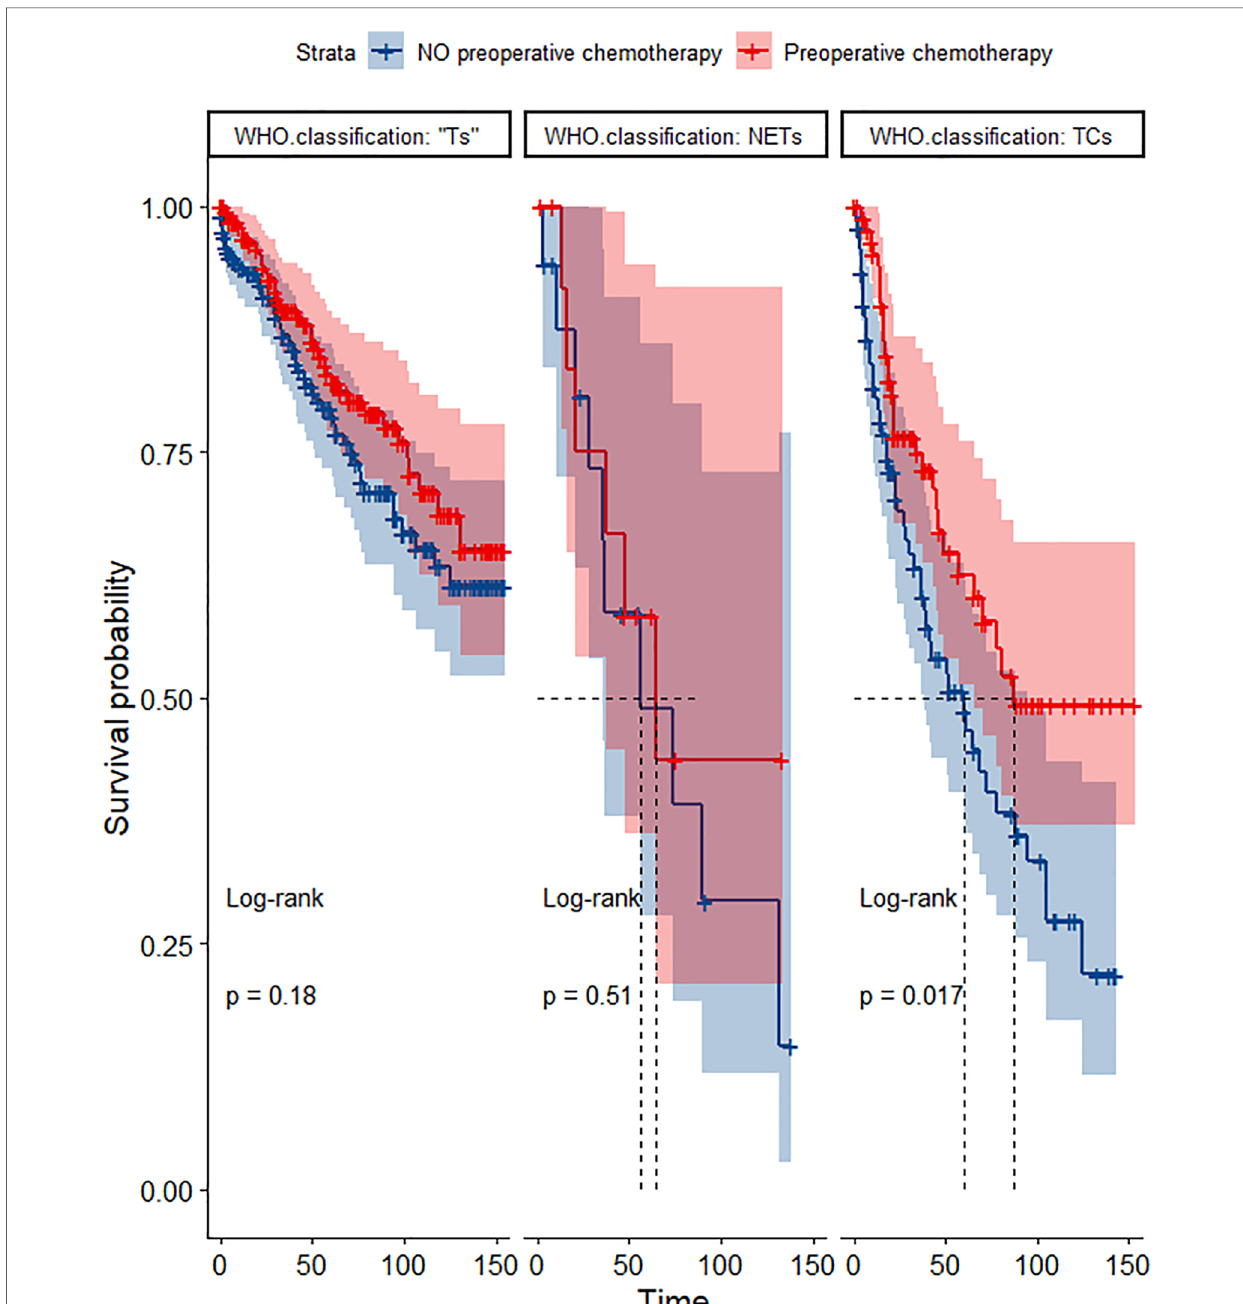
FIGURE 11 Survival curves of OS in the POCT and no POCT groups in patients undergoing surgery for TETs in different wHO classi fi cation groups after propensity